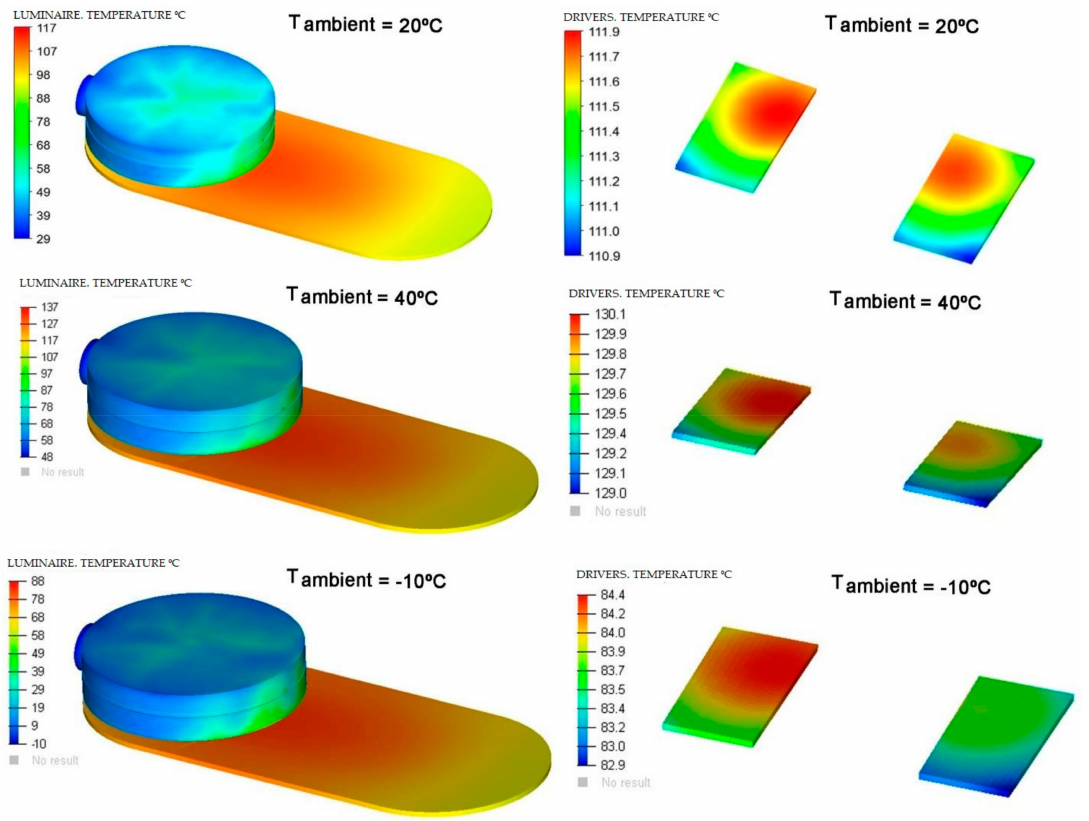
Figure 14. Temperature range of the complete luminaire and of the drivers base with respect to the ambient temperature in each simulation. Source: our own elaboration.